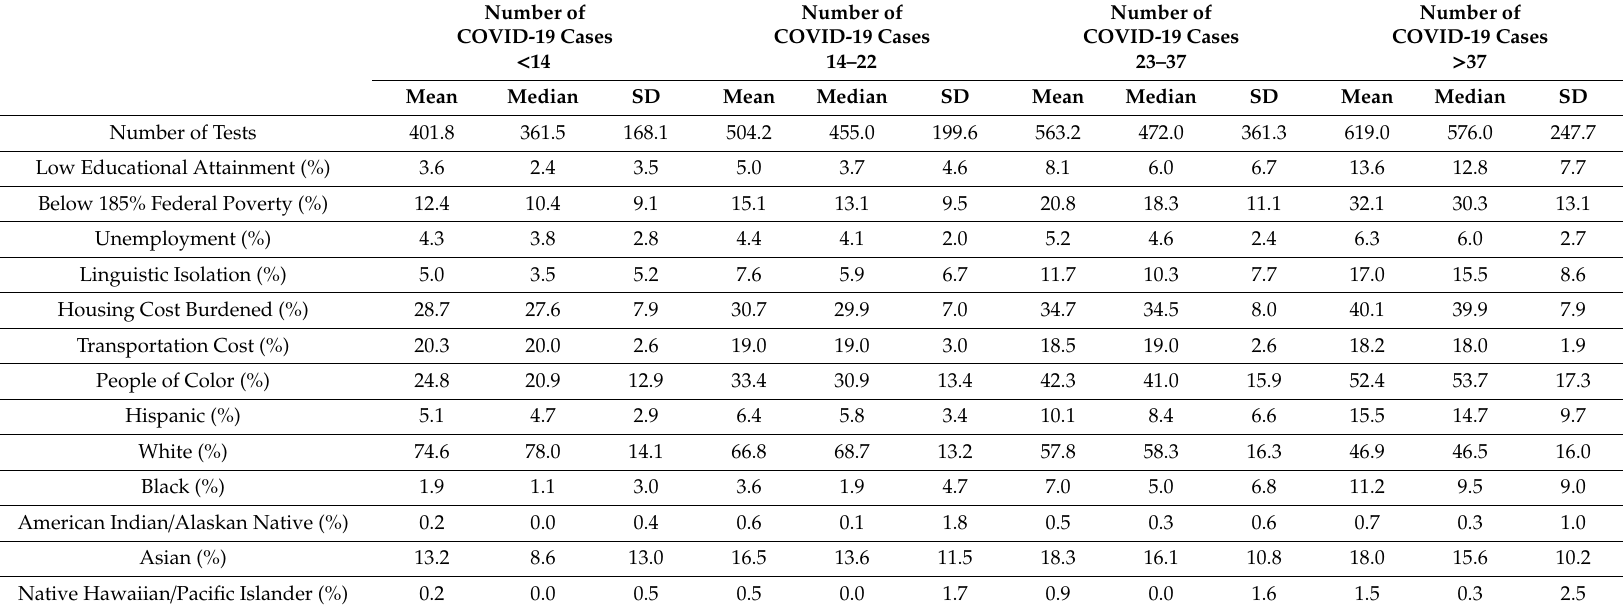
Table 1. Summary statistics of census tract-level factors by quartiles of numbers of confirmed COVID-19